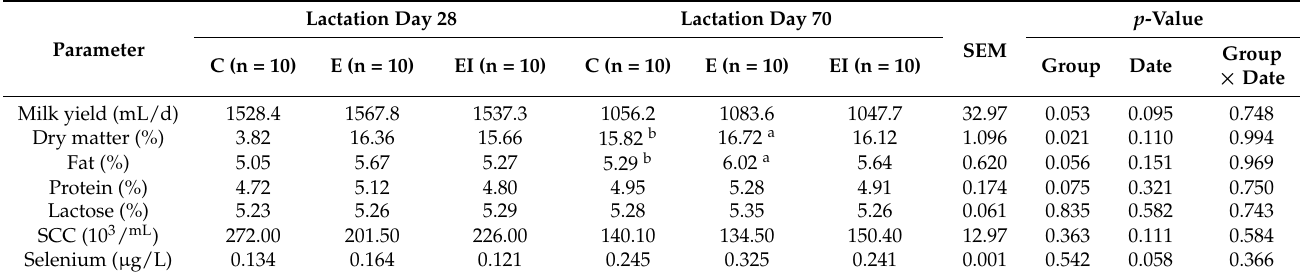
Table 2. Daily milk yield, milk composition, somatic cell counts, and selenium concentration in milk.